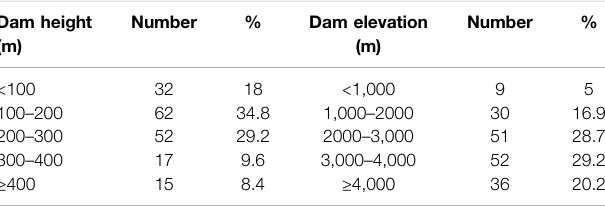
TABLE 2 | Height and elevation characteristics of natural dams in the upper Indus River.